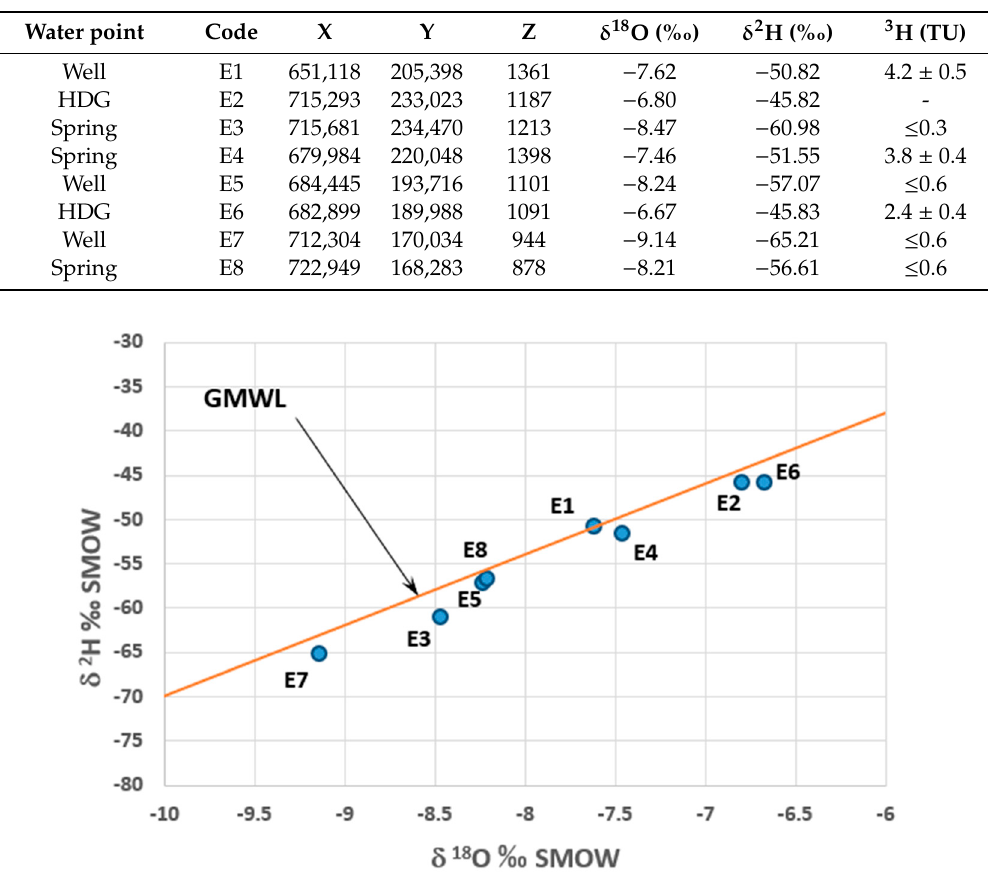
Figure 17. Relation between Deuterium and Oxygene-18 contents in groundwater samples in the study area. GMWL: global meteoric water line.